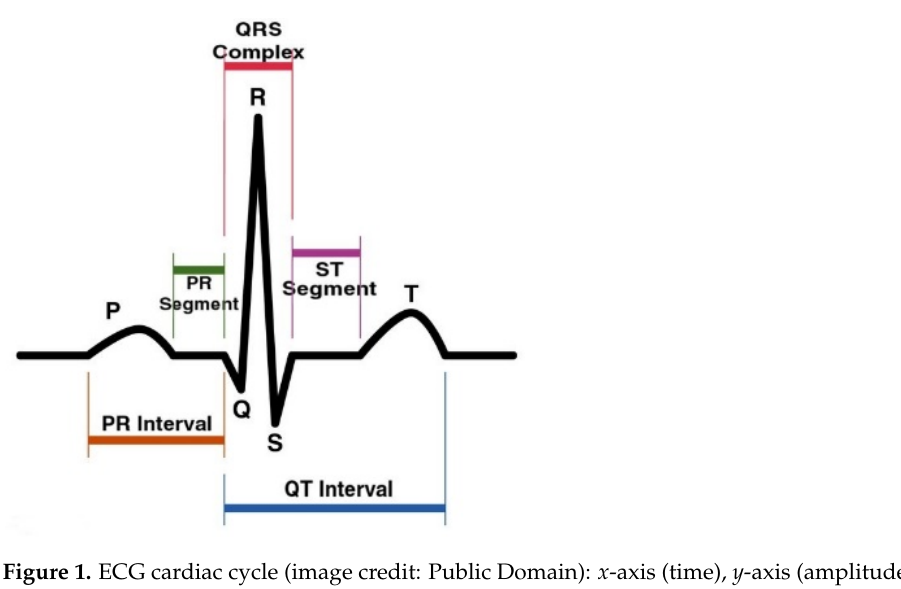
Figure 1. ECG cardiac cycle (image credit: Public Domain): x -axis (time), y -axis (amplitude in mV), typical duration (1 s).